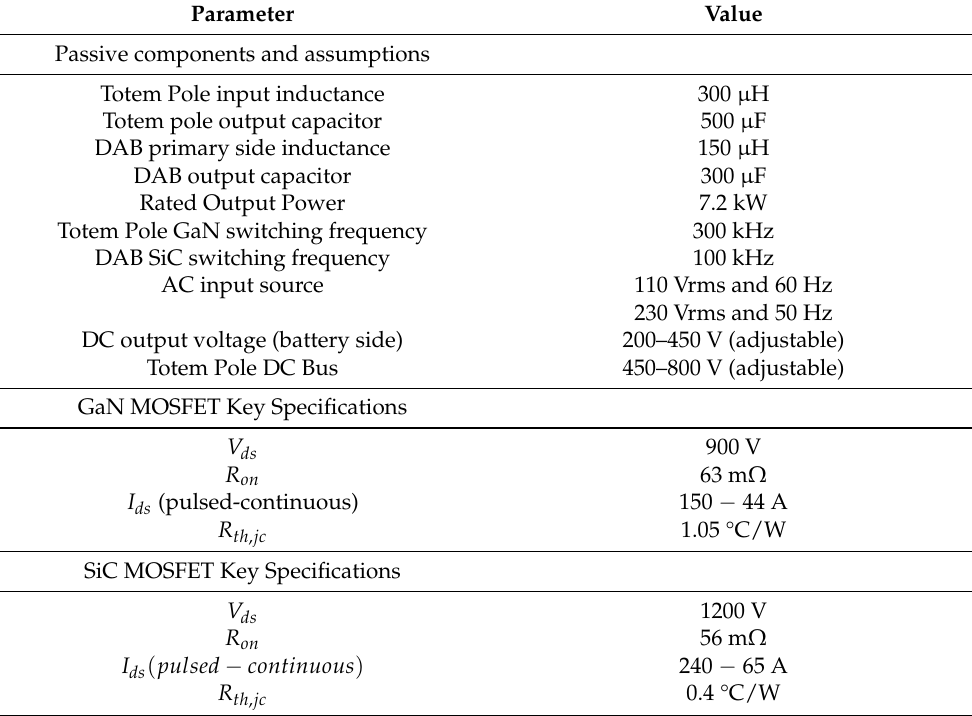
Table 1. OBC nominal parameters for simulation.